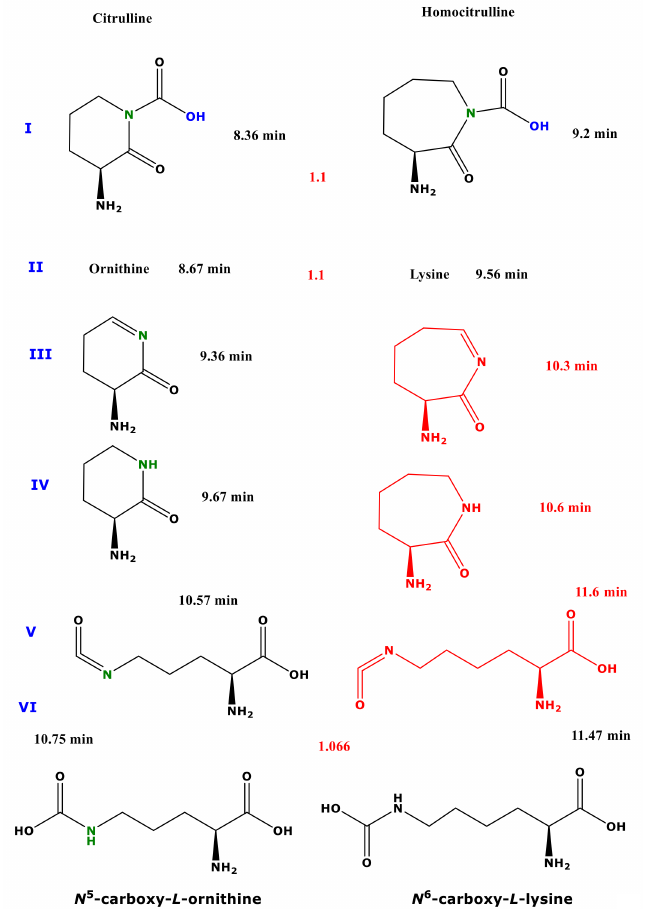
Figure 5. Proposed structures of the reaction products of citrulline (left panel) and homocitrulline (right panel) using procedure B (first PFPA/EA then 2 M HCl/MeOH). The red-marked structures were not found to be derivatization products of homocitrulline. The red numbers between the structures are the relative retention times of the homocitrulline products to the corresponding citrulline reaction